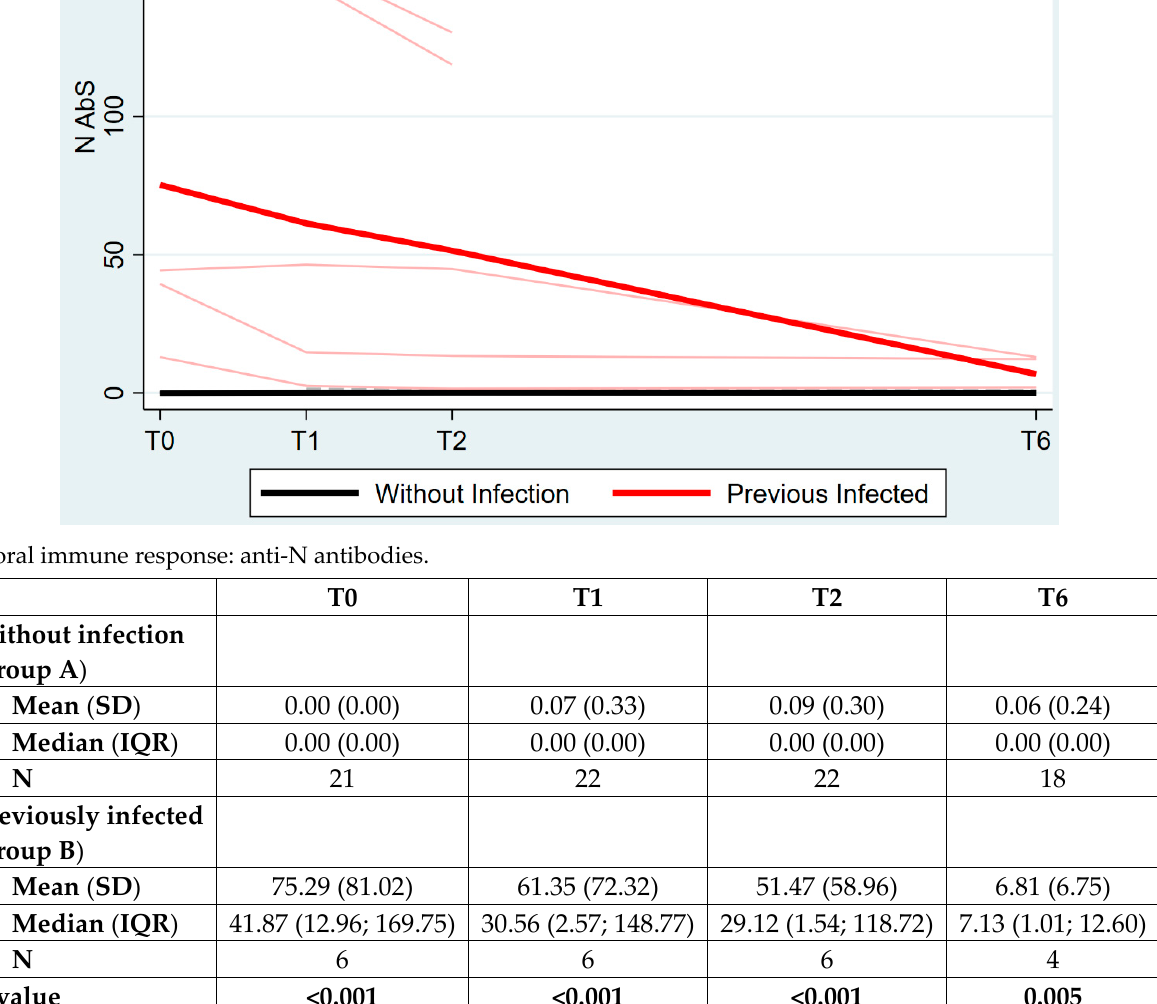
infections during the course of the study ( p <